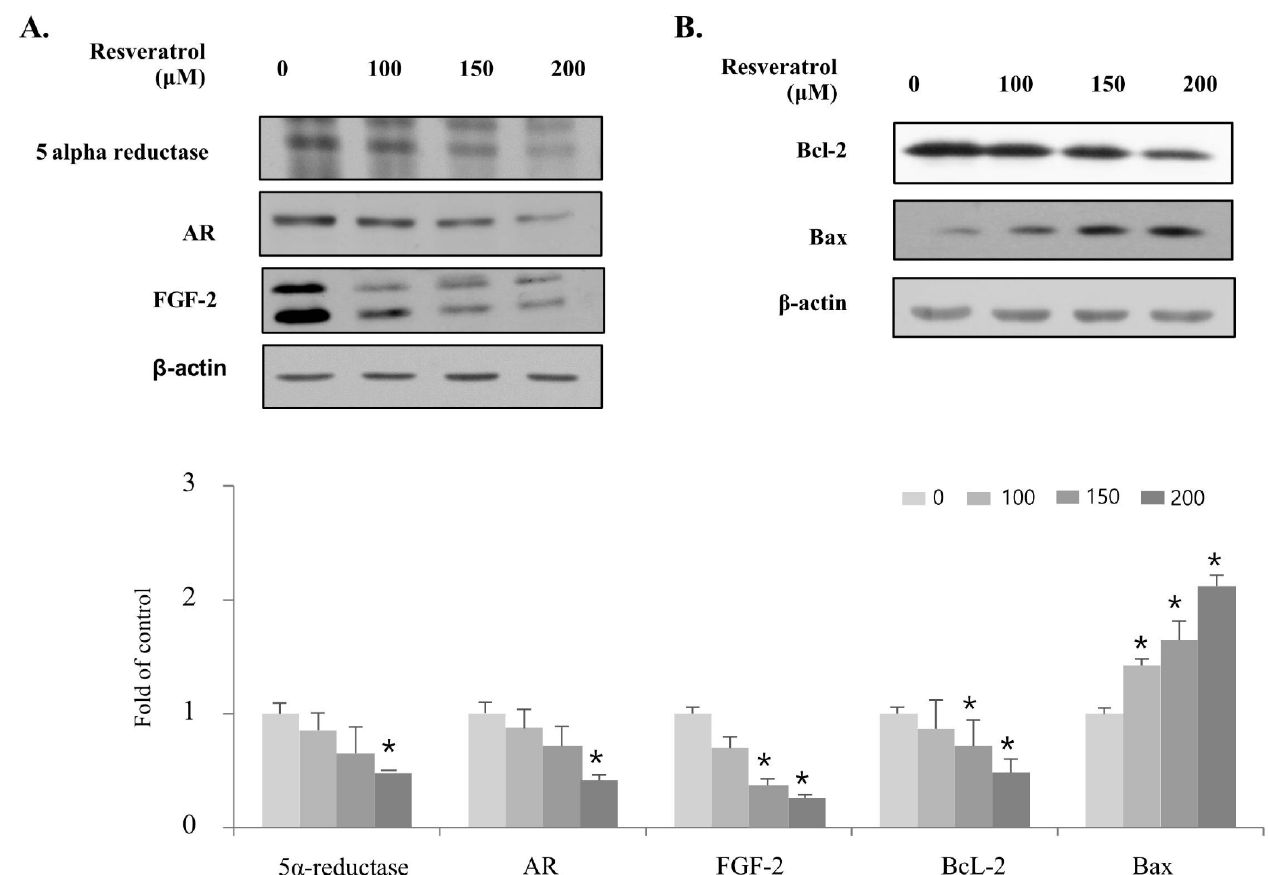
Figure 5. Regulation of the BPH marker expression in WPMY-1 cells by resveratrol treatment. Cells were incubated with resveratrol for 24 h at the indicated concentrations. ( A , B ) Changes in the BPH markers involved in prostate development progression were analyzed by immunoblot. β-actin was used as a housekeeping protein in this experiment. The data are expressed as mean ± SD as a result of three independent experiments depending on the resveratrol concentration (* p < 0.05).